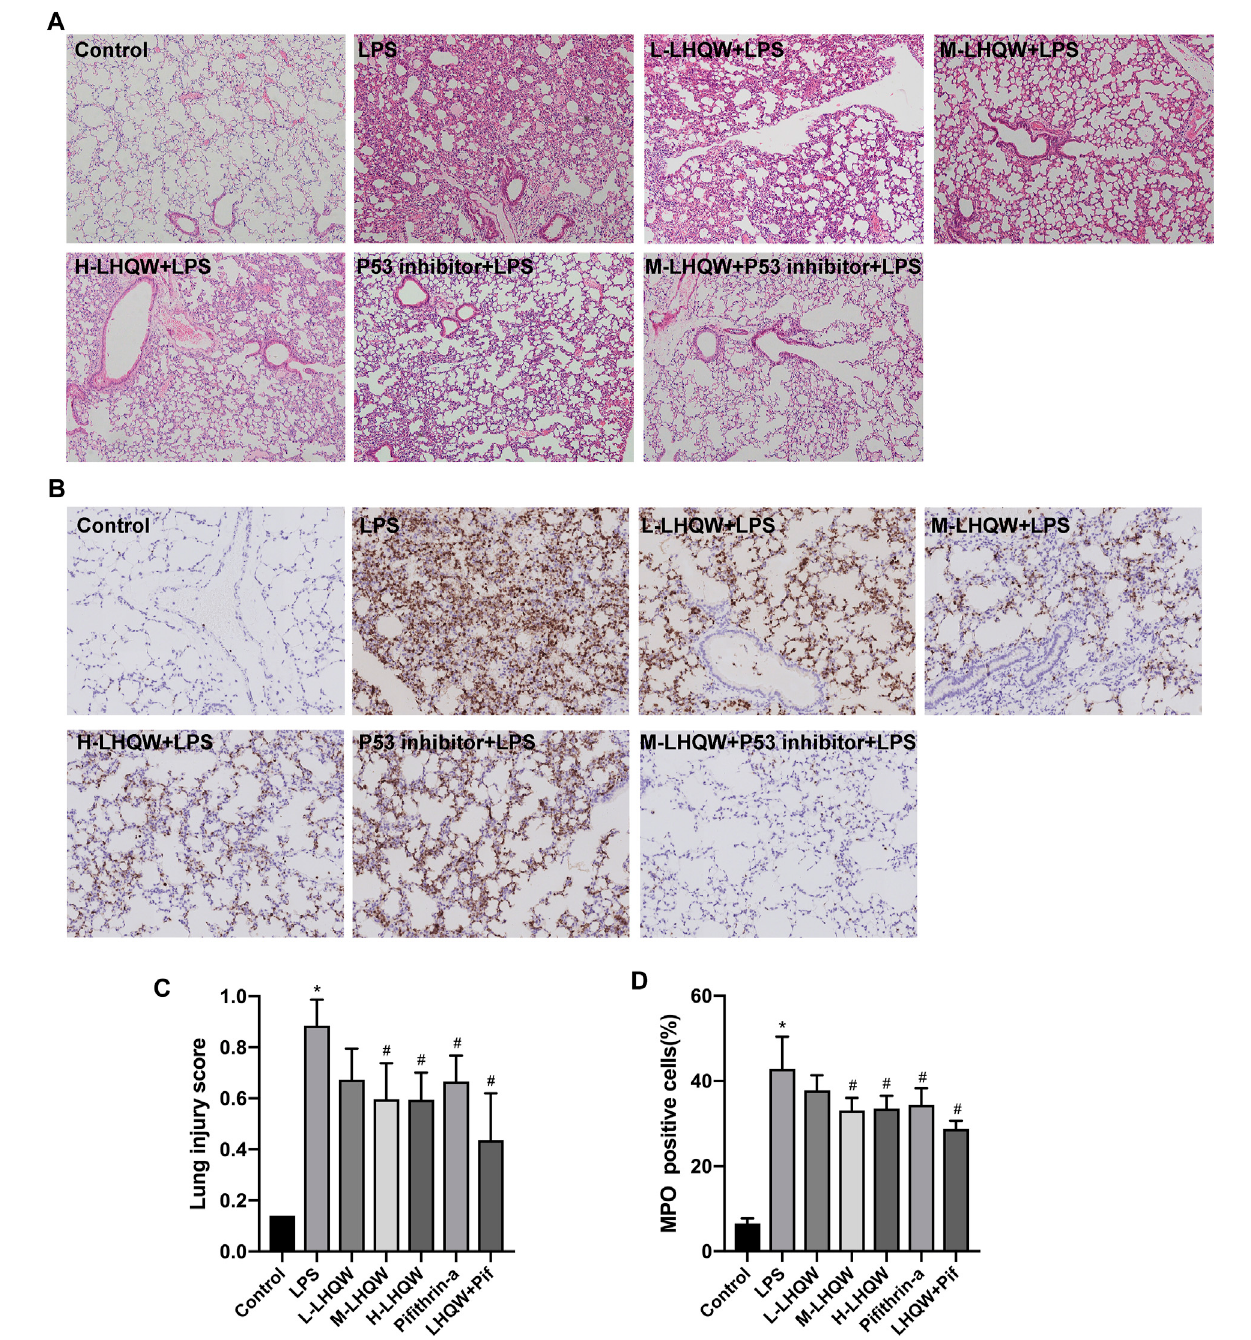
FIGURE4| Effect ofLHQW onhistologicalfeatures and MPOactivity inALImice. (A) HE staining.Magni fi cation, × 100 (B) Thelevels ofMPOinmouse lung tissues fromdifferentgroups.BrownstainingindicatesMPO-positiveexpression.Magni fi cation, × 200 (C) Lunginjuryscoresweremeasuredin20random fi eldsoflungsections accordingtoHEstaining(400 × totalmagni fi cation),takenfromthreemiceineachgroup. (D) ThepercentagesofMPO-positivecellswerecountedinthree fi eldsofalung section. LPS, 5 mg/kg; L-LHQW, 700 mg/kg/day; M-LHQW, 1,400 mg/kg/day; H-LHQW, 2,800 mg/kg/day; p53 inhibitor, pi fi thrin- α (3 mg/kg/day). Data are shown as mean ± SD from one-way ANOVA followed by Tukey ’ s post-hoc test. * p < 0.05, versus Control; # p < 0.05, versus LPS.